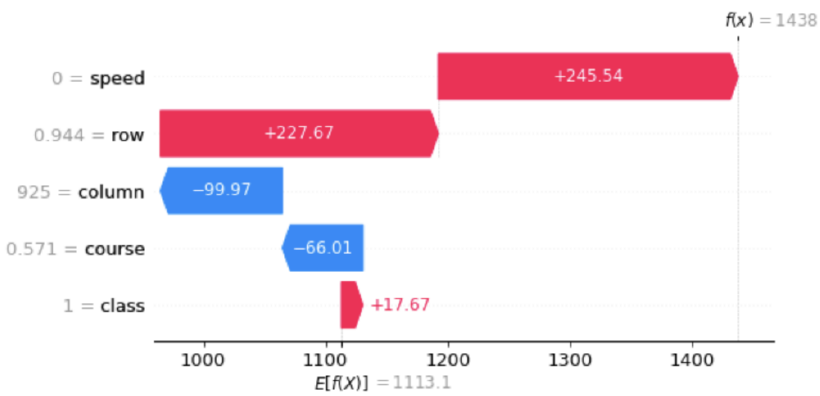
Figure 8. The contribution of each input feature to build the output predicted by KNN-WD for ship 26.